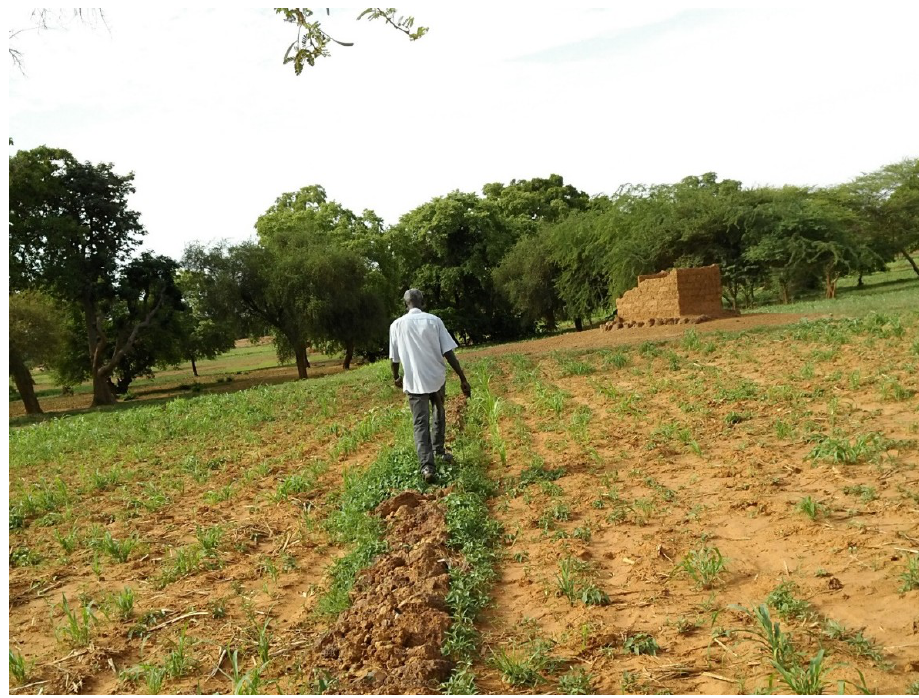
Figure 3. Contour stone bund ("diguette"), Commune of Kongoussi, July 2017 - Photo by Colin Thor West.